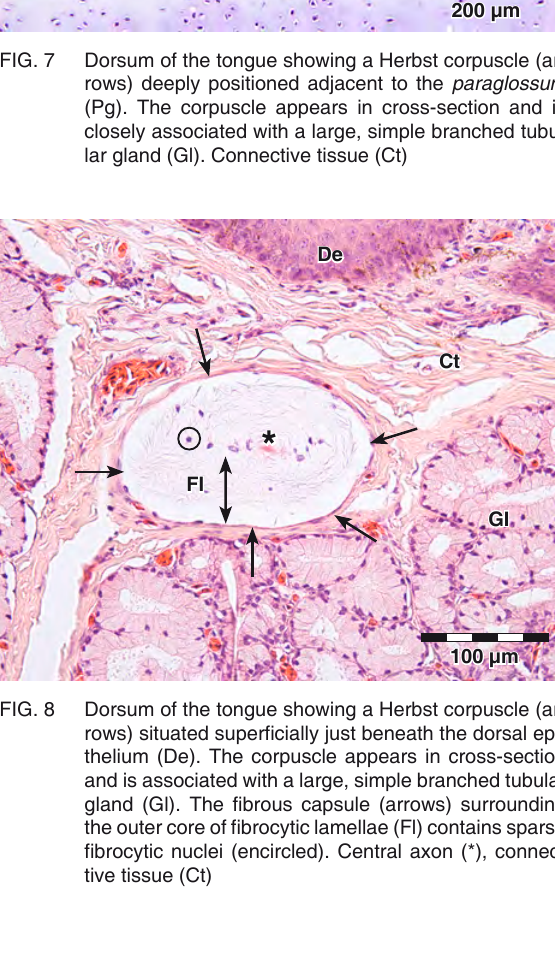
served to penetrate the epithelium, obliterating the normal structure of this layer. Infiltration of the glan­ dular tissue, particularly in the vicinity of the lumen and secretory duct, is also obvious (Fig. 9). Nodular